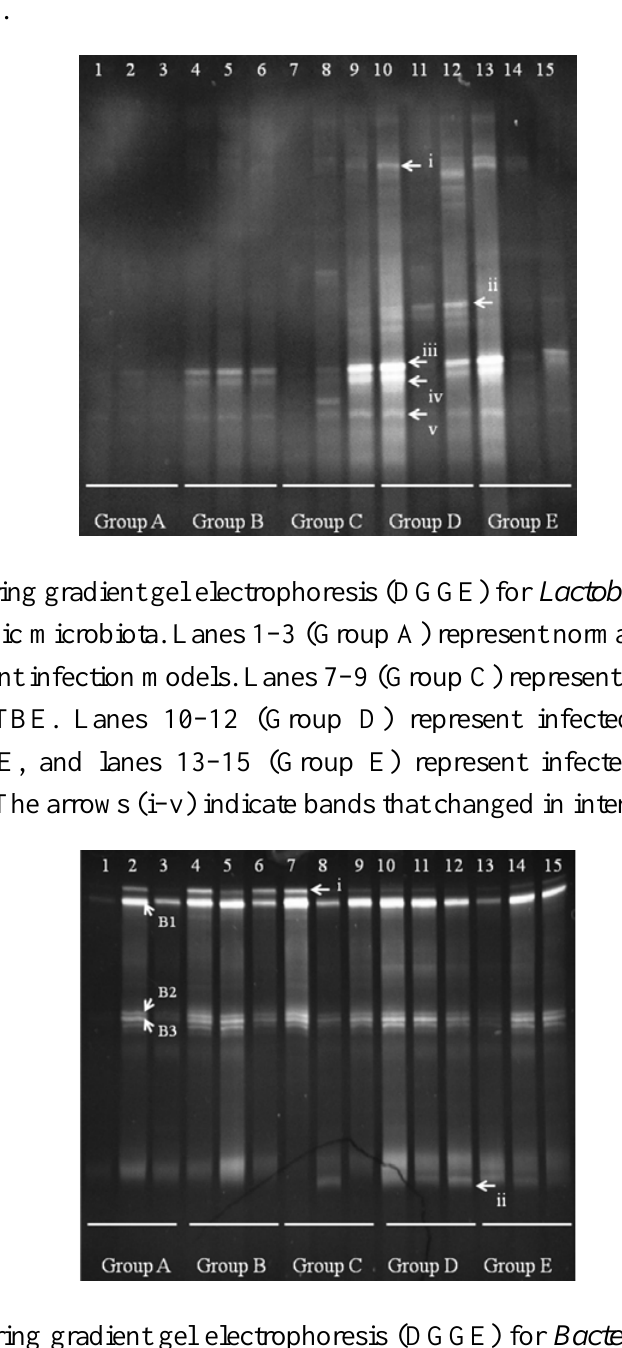
Figure 5. Denaturing gradient gel electrophoresis (DGGE) for Bacteroides obtained from mouse distal colonic microbiota. Lanes 1–3 (Group A) represent normal controls. Lanes 4–6 (Group B) represent infection models. Lanes 7–9 (Group C) represent infected mice treated with low-dose FTBE. Lanes 10–12 (Group D) represent infected mice treated with middle-dose FBTE, and lanes 13–15 (Group E) represent infected mice treated with high-dose FBTE. The arrows (i–ii) indicate bands that changed in intensity. Representative bands (B1–B3) were excised for cloning and